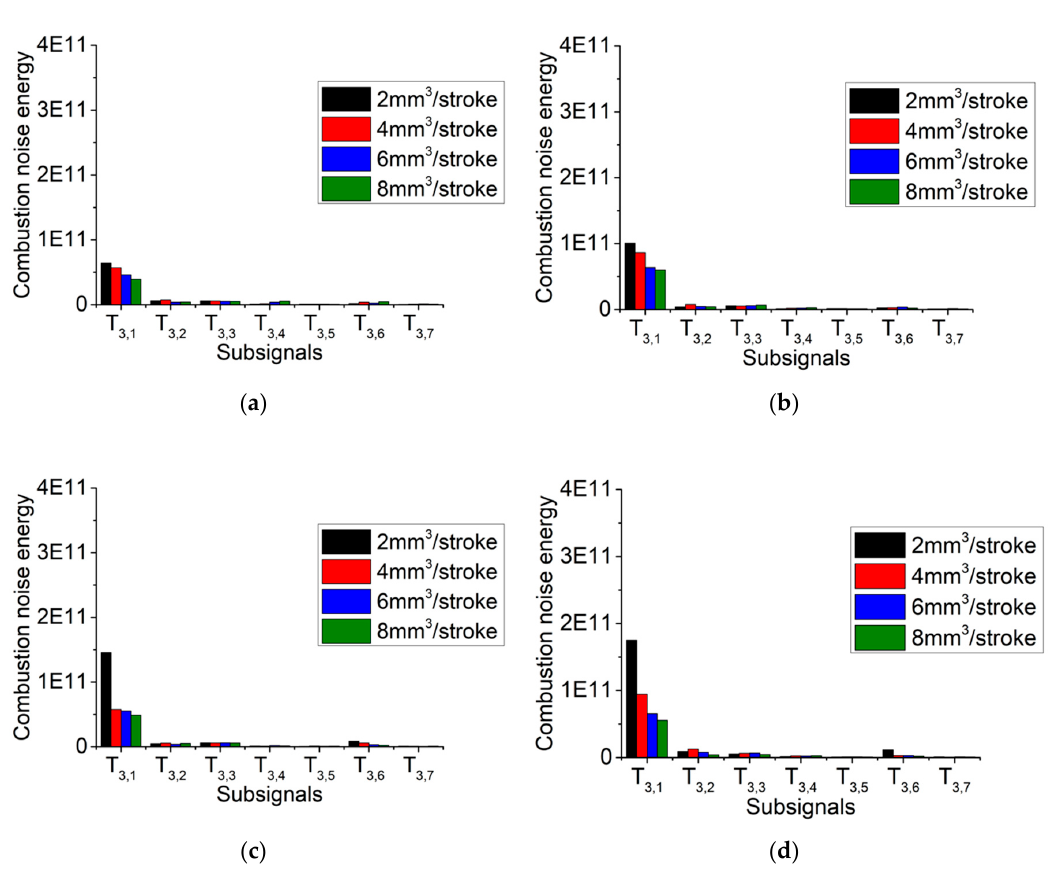
Figure 11. Main combustion noise energy of seven sub-signals. ( a ) Pilot injection timing = − 9° ATDC; ( b ) pilot injection timing = − 14° ATDC; ( c ) pilot injection timing = − 19° ATDC; ( d ) pilot injection timing = − 24° ATDC.